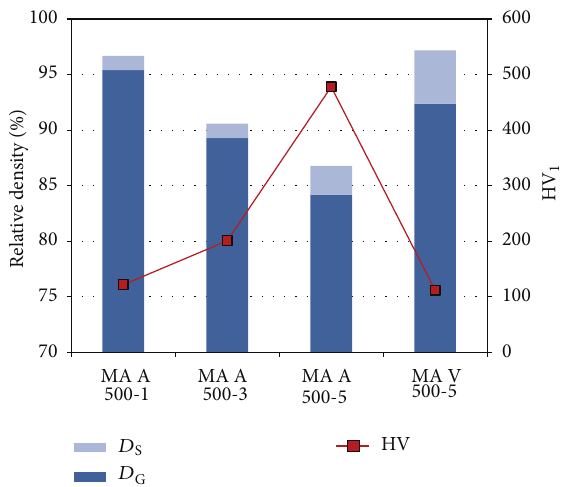
Figure 7: Green ( 𝐷 ) and sintered ( 𝐷 ) relative density and Vickers G S hardness of sintered compacts from powders milled at 500 rpm in vacuum for 5 h and in an ammonia flow for 1, 3, and